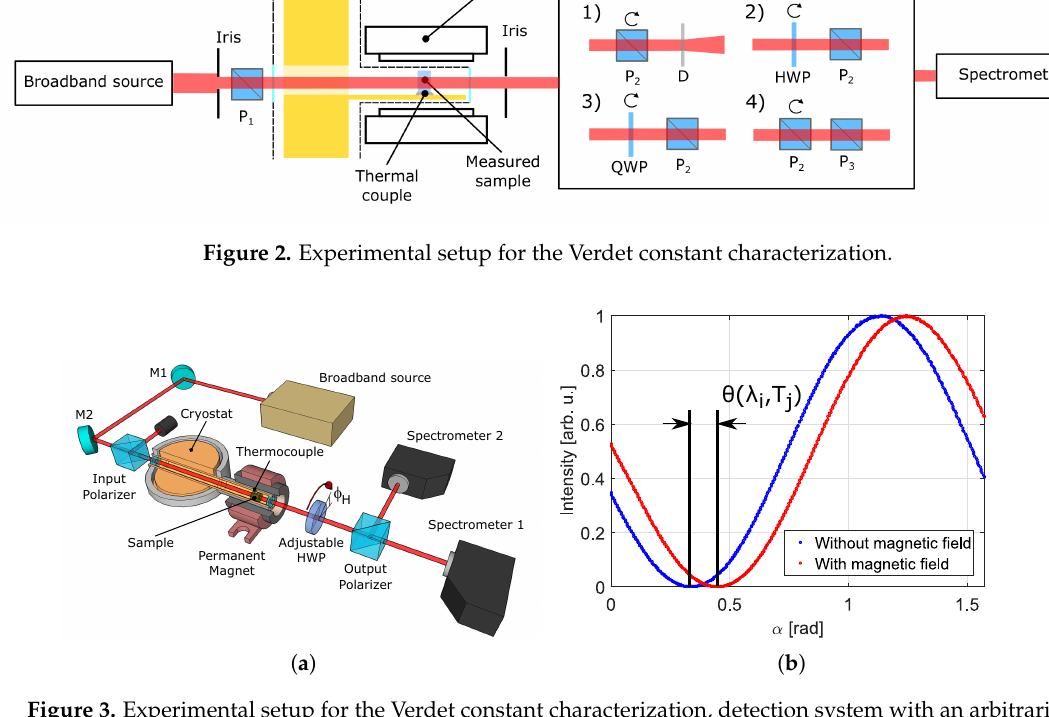
Figure 3. Experimental setup for the Verdet constant characterization, detection system with an arbitrarily rotated half-wave plate [48]: ( a ) a 3D overview of the experimental setup; and ( b ) an example of data obtained at a single wavelength and